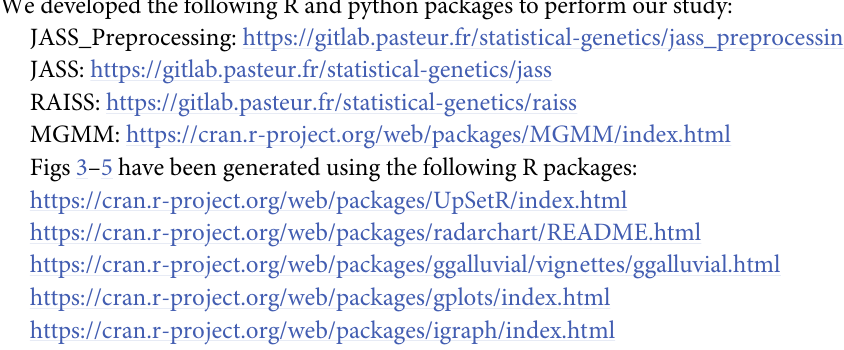
S1 Fig. Distribution of the proposed statistics under the null. We simulated series of 10,000 replicates, each including z-score statistics for 5 (panels a-c) and 100 (panels d-f) phenotypes and 100K SNPs. For each replicate we applied the Omnibus test (panels a and d), the sumZ test using weights of 1 (panels c and f) and test sumZ test using weights equals to loading of the first principal component of the phenotypic correlation matrix. Left panels show the observed chi-square distribution in blue against the expected one in red. Right panels show the corre- sponding p -value histograms. S2 Fig. Solving singular covariance matrices. We simulated series of replicates, each includ- ing 20,000 individuals, 10,000 SNPs additively coded with frequencies ranging from 0.01 to 0.99, and 100 phenotypes. The phenotypes were drawn from a multivariate normal distribu- tion with mean 0 and a variance-covariance S of rank 50. For each SNP, we computed the z- r score of association with each phenotype using linear regressions and then derived p -values from the Omnibus test using three strategies to derive the inverse of S : i) considering only r eigenvalues greater than a specified threshold � (left column), ii) replacing eigenvalues below a threshold � by � (middle column), and iii) adding a small value � to the diagonal terms of S r (right column). For each strategy we considered three different � values: 10 − 3 (first